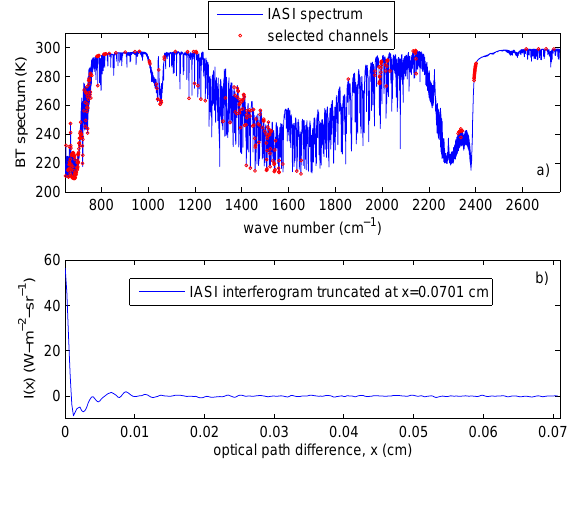
Figure 5. (a) Example of IASI spectrum, R ( σ ) , with the indication of the 300 IASI channels routinely monitored at ECMWF and (b) interferogram truncated at x a way to retain only 300 interferogram data